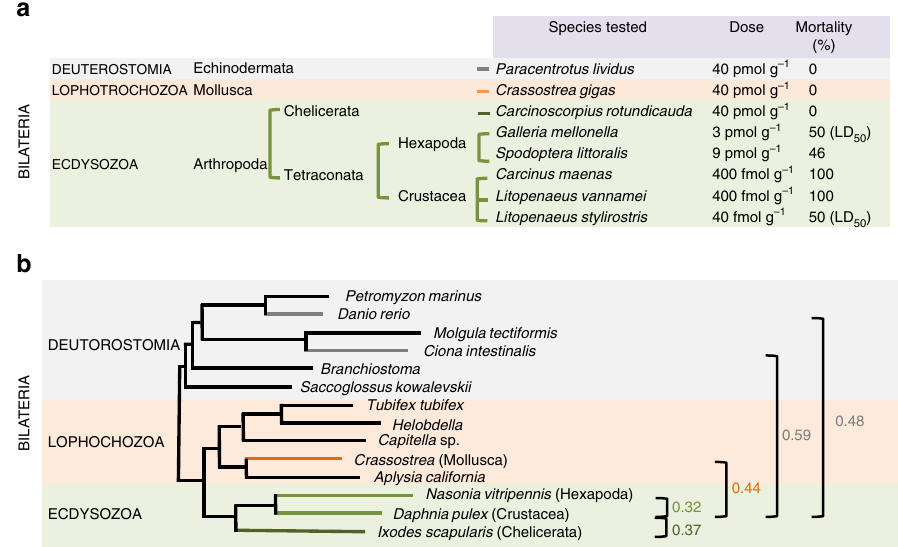
Fig. 1 Toxicity of the nigritoxin for several species of bilateria. a Percentage of mortality obtained after injection of the indicated dose of nigritoxin to different species representative of diverse phyla within the Bilateria. The LD 50 was determined for Litopenaeus stylirostris and Galleria mellonella using Probit analysis (Supplementary Fig. 1). b Evolutionary distances in substitutions/site (right side) between Crustacean and Hexapoda (light green), Chelicerata (dark green), Mollusca (orange), and two Deutorostomia Ciona intestinalis and Danio rerio (gray). The tree is adapted from Nosenko et al. 52 who analyzed a matrix composed of 22,975 homologous amino-acid